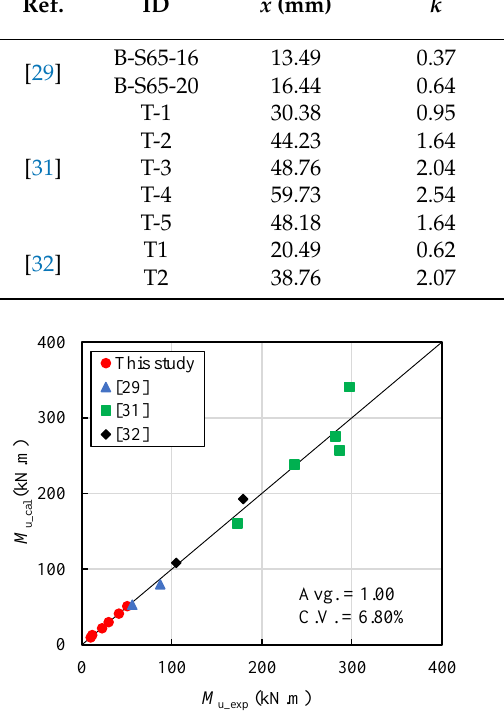
Table 8. Validation of proposed equations in previous studies. Figure 15. M u_cal versus M u_exp in this study. Ref.